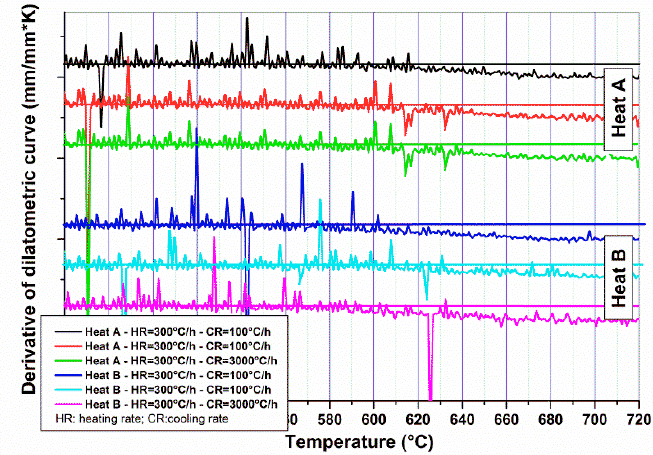
Figure 3. Derivatives of dilatometric curves of Heat A and Heat B samples. Different curves have